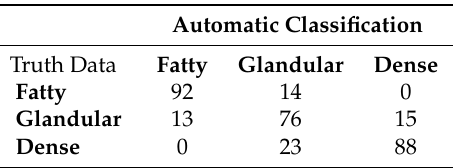
Table 5. Confusion matrix for automatic tissue classification using the Mean Elliptical Local Binary Pattern (M-ELBP) descriptor for ROI size 256 × 256 and R = { 4,7 } and P = 8.